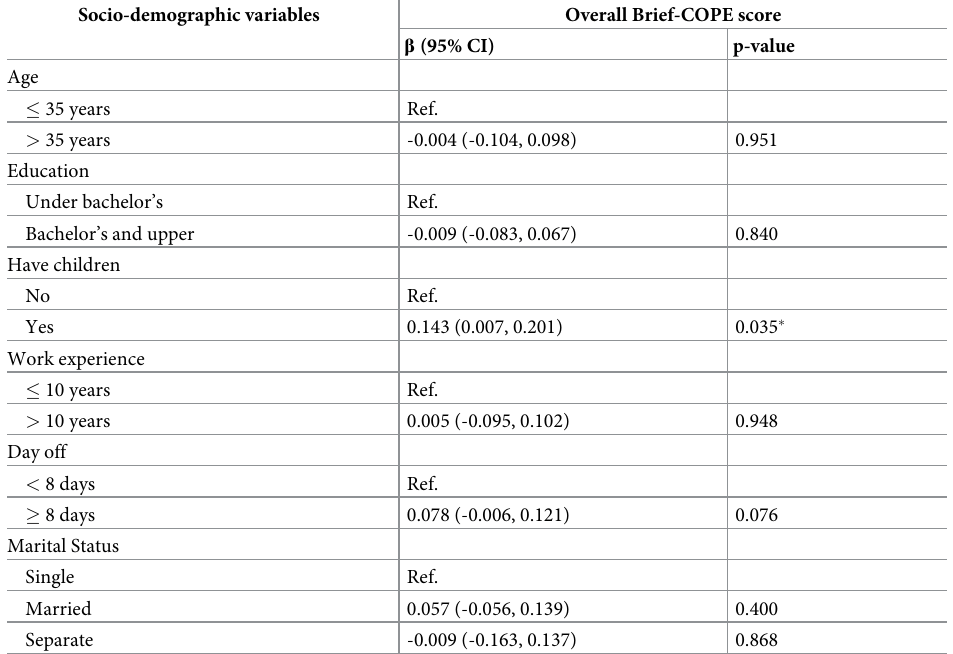
Table 3. Socio-demographic variables associated with overall Brief-COPE score.